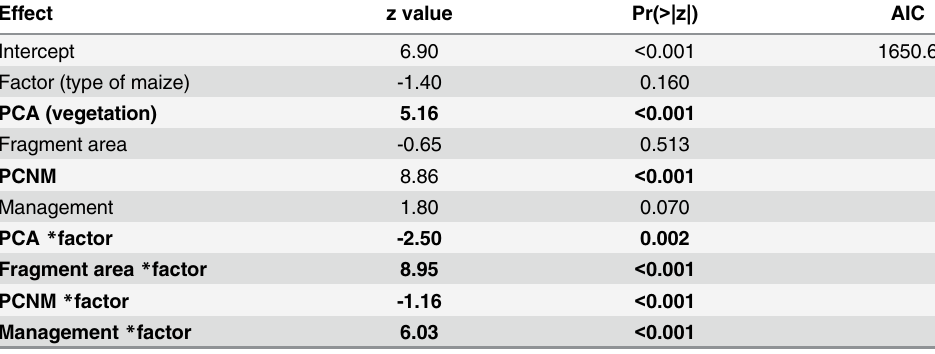
Table 2. GLMM ’ s results of explanatory variables of dung beetle communities in 20 fragments adja- cent to transgenic and 20 fragments adjacent to conventional maize, in Campos Novos,